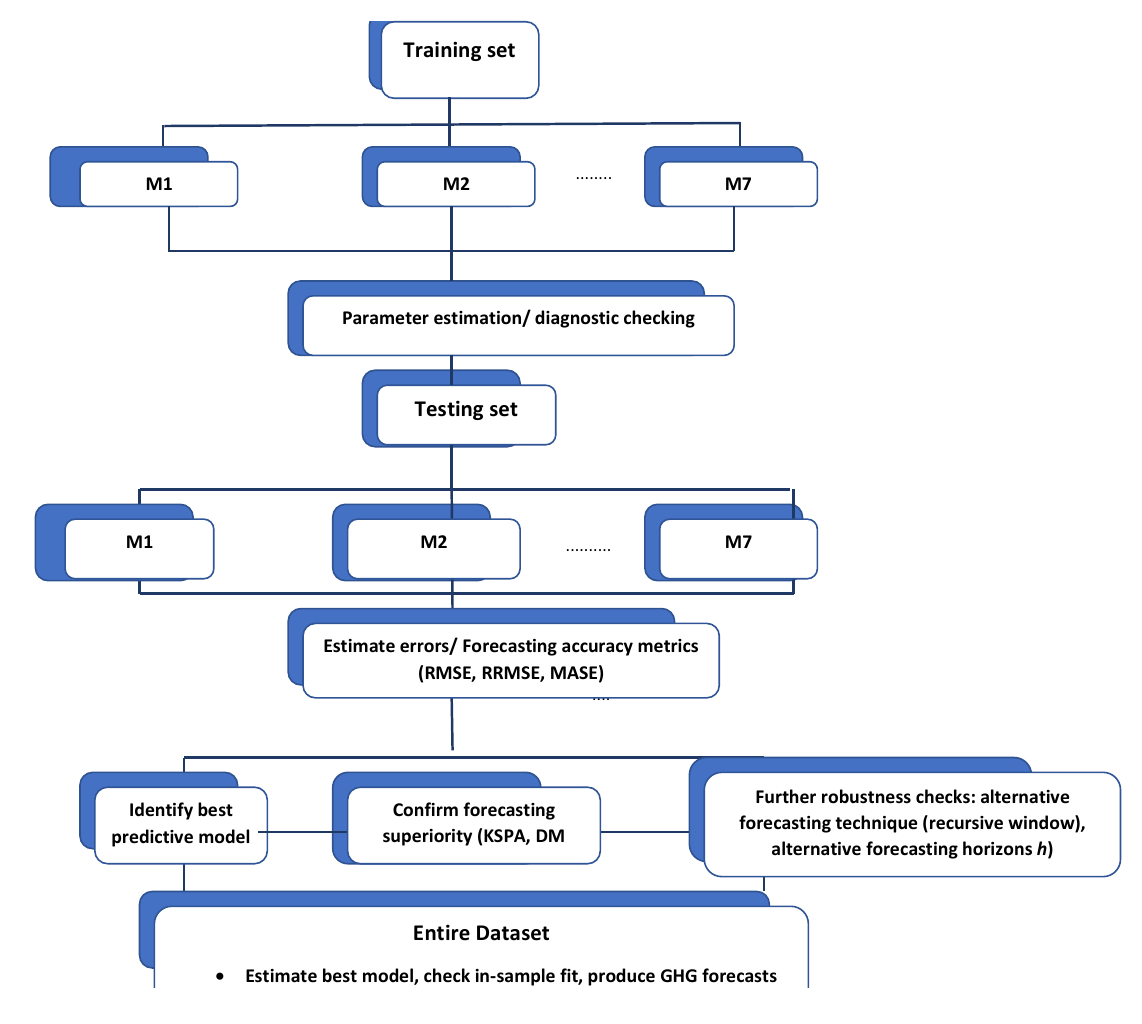
Figure 8. Sequential steps of the forecasting procedure.